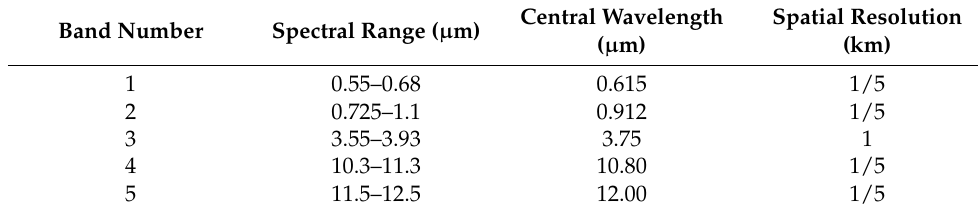
Table 1. AVHRR/2